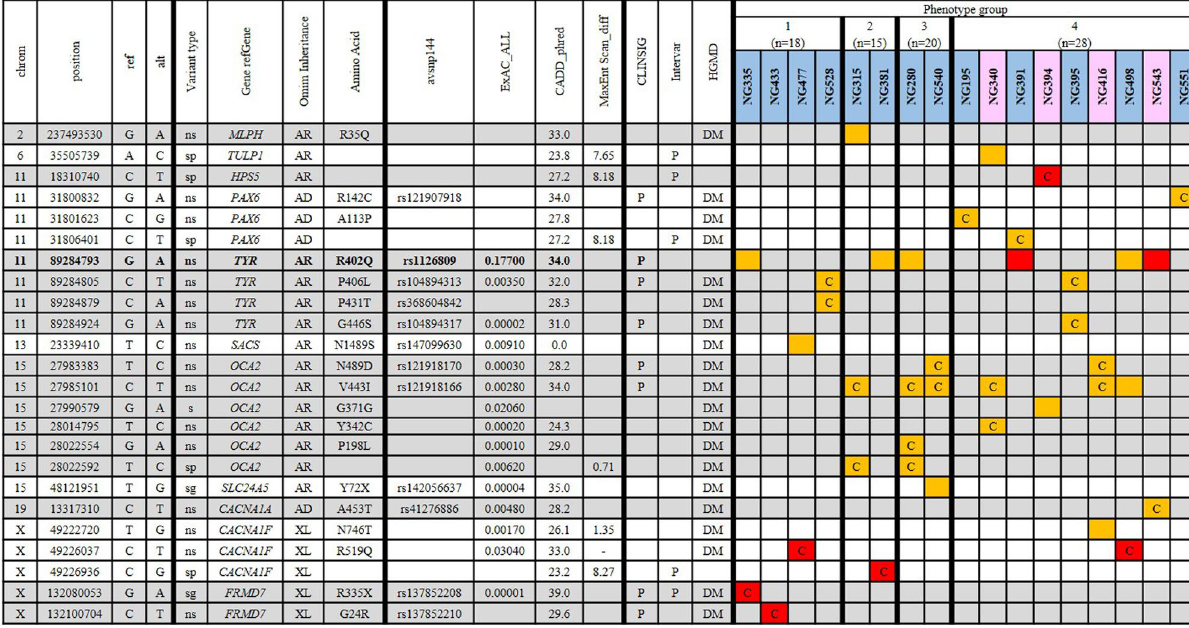
Figure 1. Seventeen of 81 patients with assumed pathogenic variants were determined to harbour likely causal genotypes. Samples, blue background indicates male whilst pink indicates female, orange cells indicate heterozygous variants and red cells indicate homozygous and hemizygous variants. Samples are ordered by phenotypic group, and cells with a ‘C’ denote assignment of a likely causal variant. The TYR